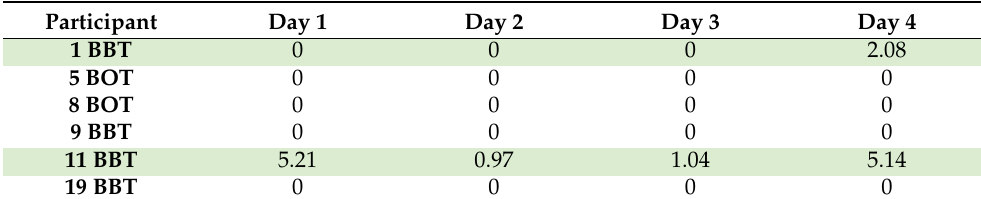
Table 3. Time below range (TBR) during 24 h measurements (08.00 AM–07.59 AM next day) in insulin-treated participants. Participants No.1 and No. 11 showed hypoglycemic episodes.